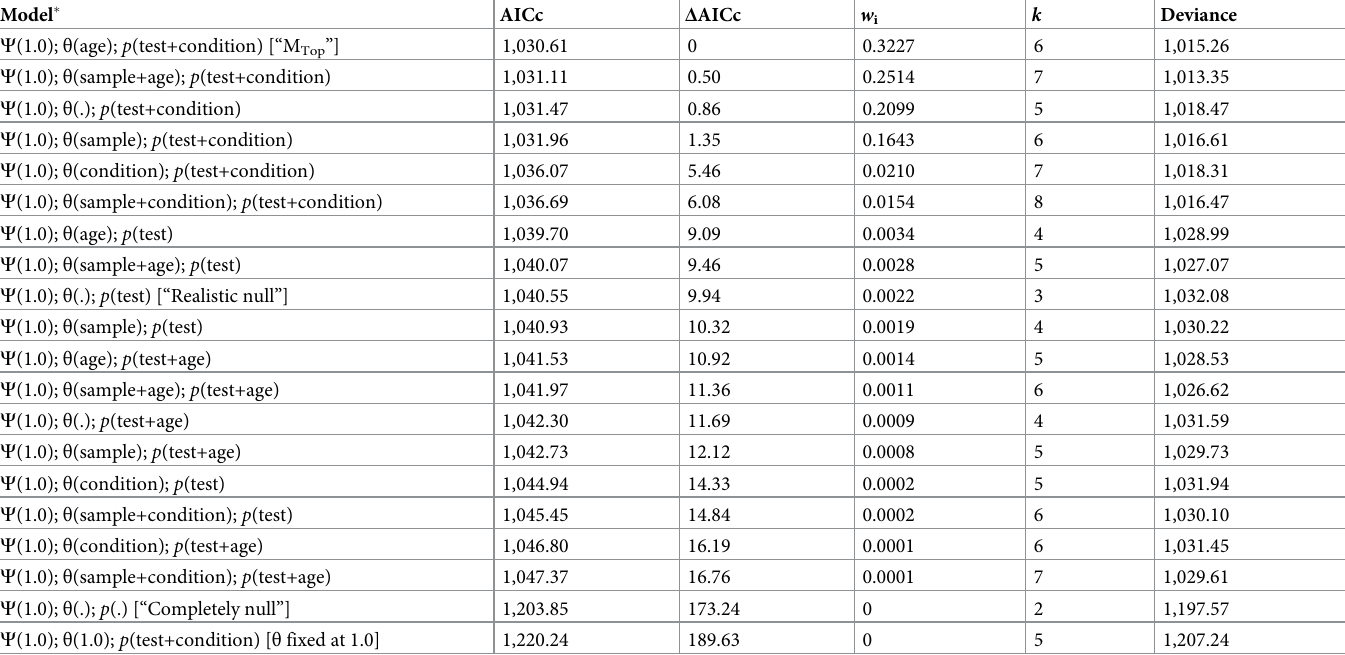
Table 1. The complete 20-model set. Model �